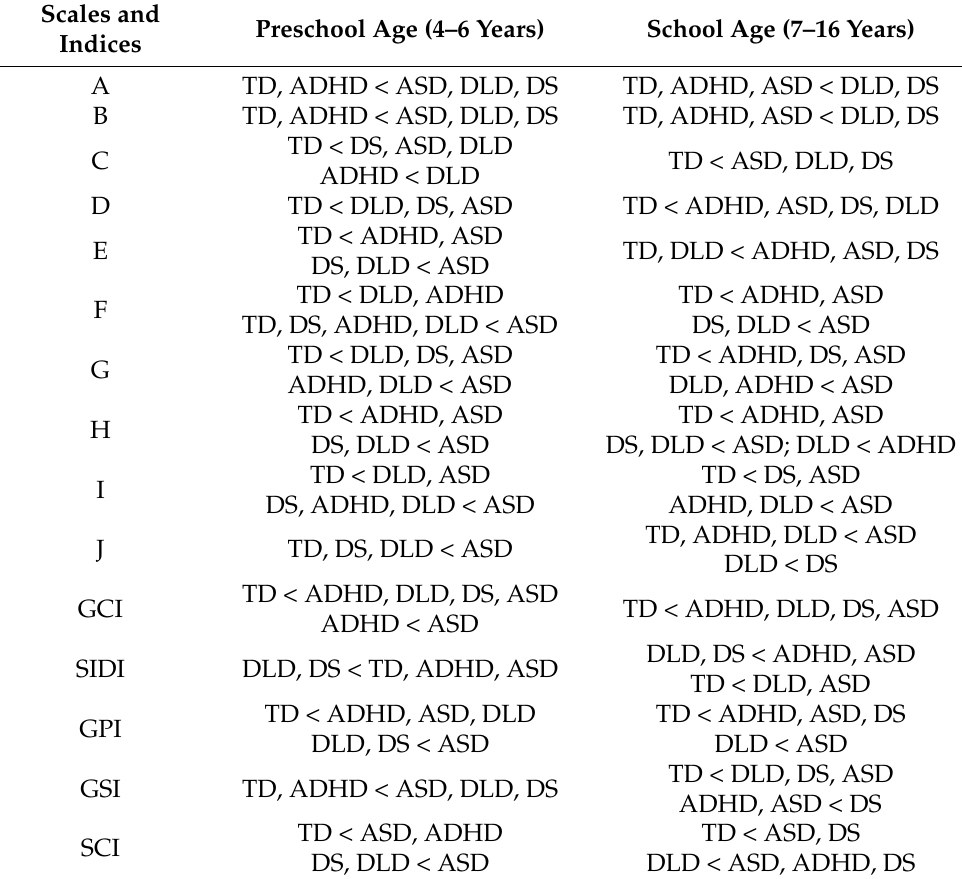
Table 6. Post-hoc analysis: comparison between the groups of children with TD, ASD, ADHD, DLD and DS in the 10 scales and 5 indices of the Galician CCC-2 at preschool and school